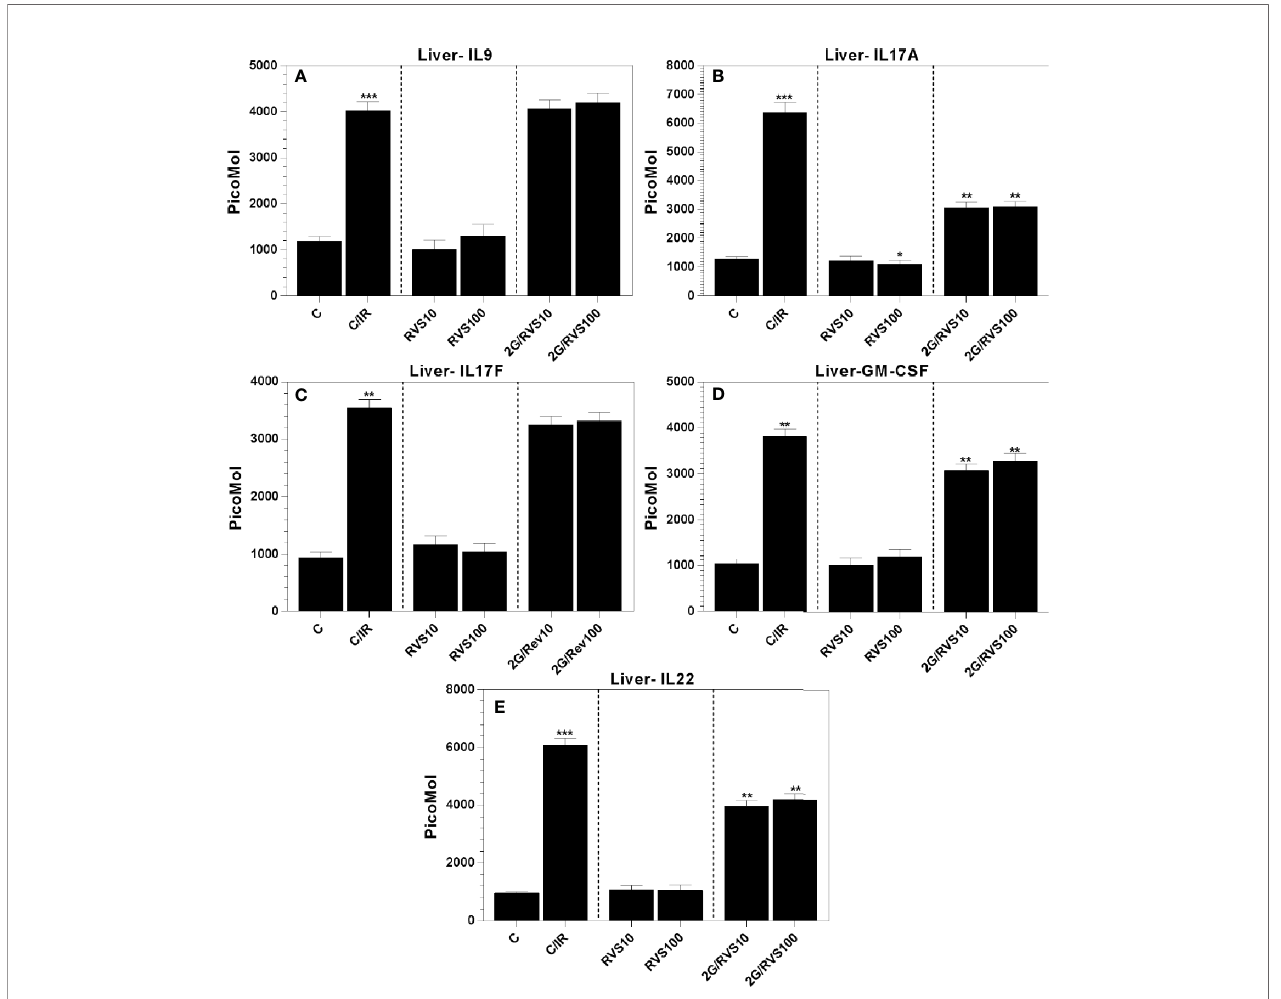
FIGURE 3 | The cytokine pro fi les in Wistar rat liver produced by Th9,Th17, and Th22 cells which include (A) IL-9, (B) IL-17A, (C) IL-17F, (D) GM-CSF and (E) IL-22 in six rat groups. (C, control group; C/IR, irradiated rats, RSV10 and RSV100; irradiated rats with 2 Gy pretreated with resveratrol 10 mg 100 mg/kg body weight, respectively). C/IR are compared to C; RSV10 or RSV100 are compared to C; 2G/RSV10 or 2G/RSV100 are compared to C/IR. *p < 0.05, **p < 0.01, ***p <